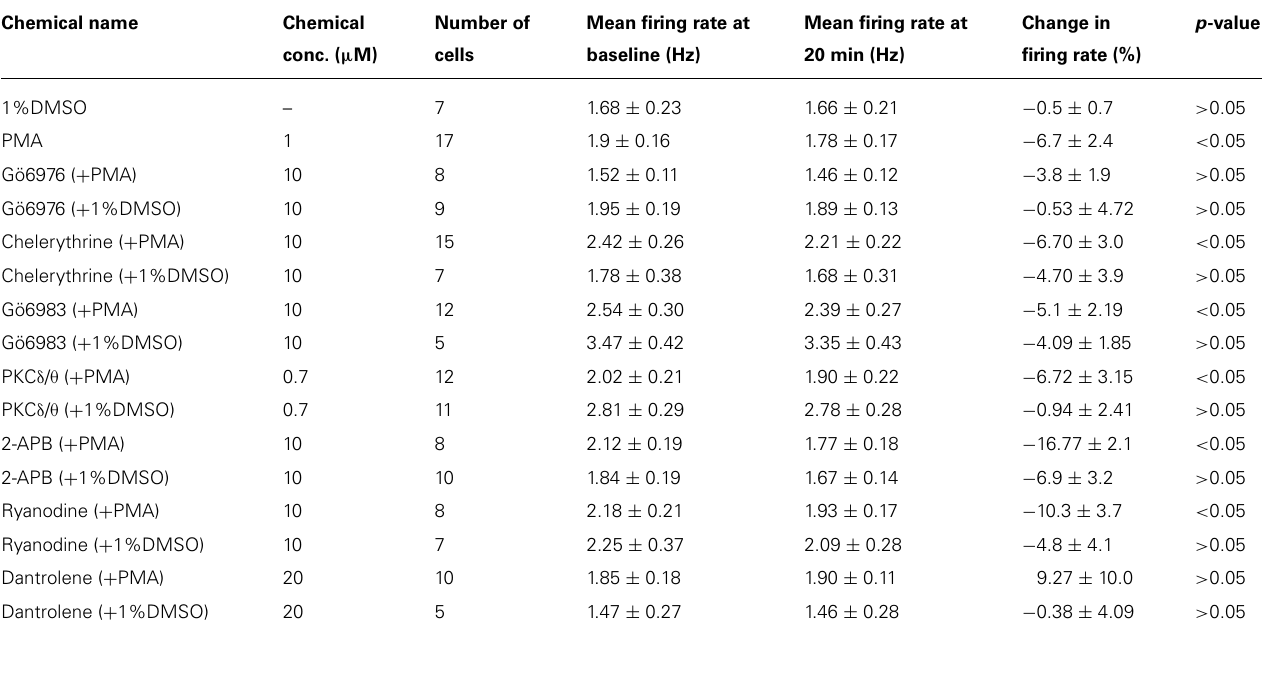
Table 1 | Changes in firing rate in response to PMA and/or